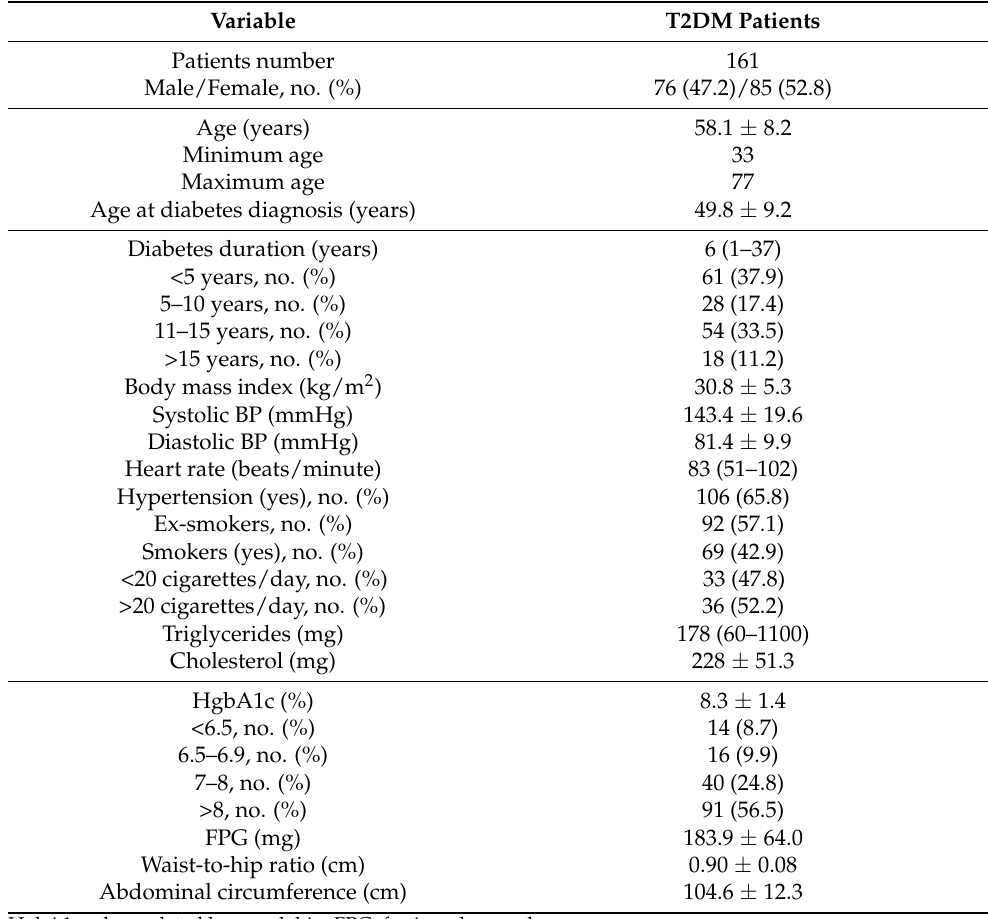
Table 1. Demographic and clinical characteristics of the study population.